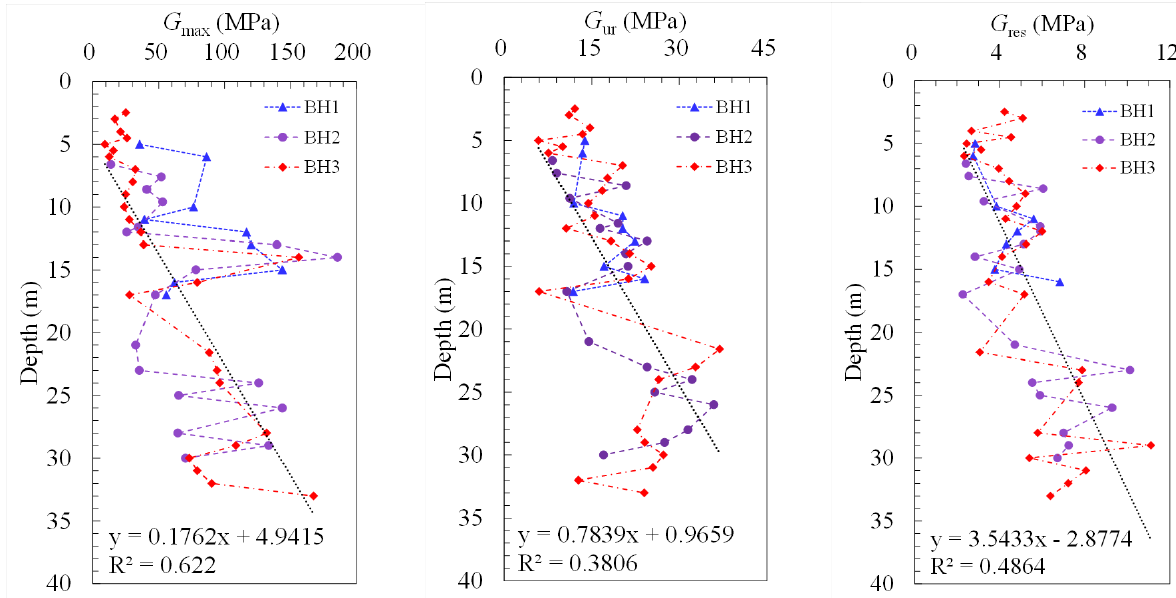
Figure 10. Distribution of the shear modulus along the